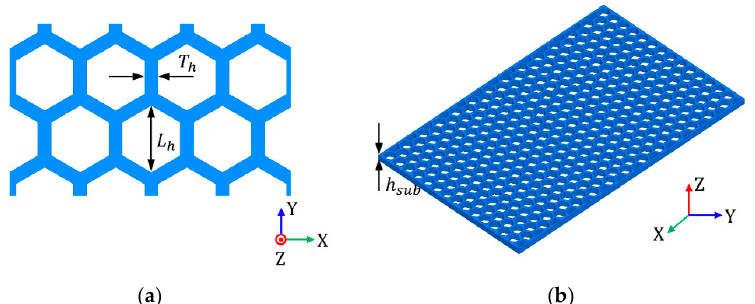
Figure 1. Schematic of the proposed honeycomb ( a ) unit cell, with size: L h = 2.5 mm and thickness: T h = 0.85 mm; and ( b ) substrate, with height: h sub = 1 mm.